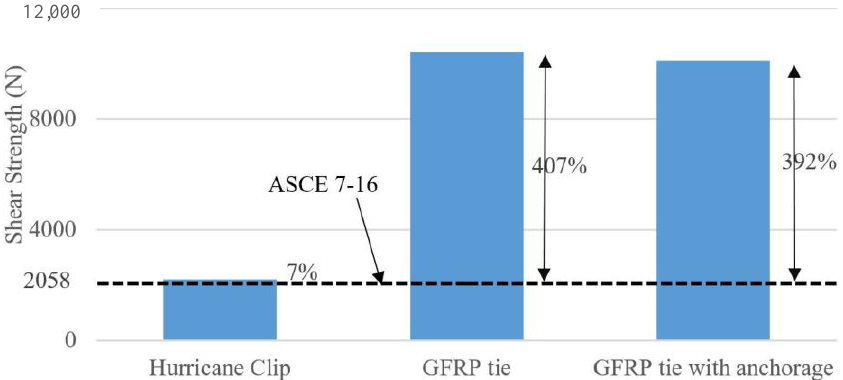
Figure 16. Improvement in shear capacity.